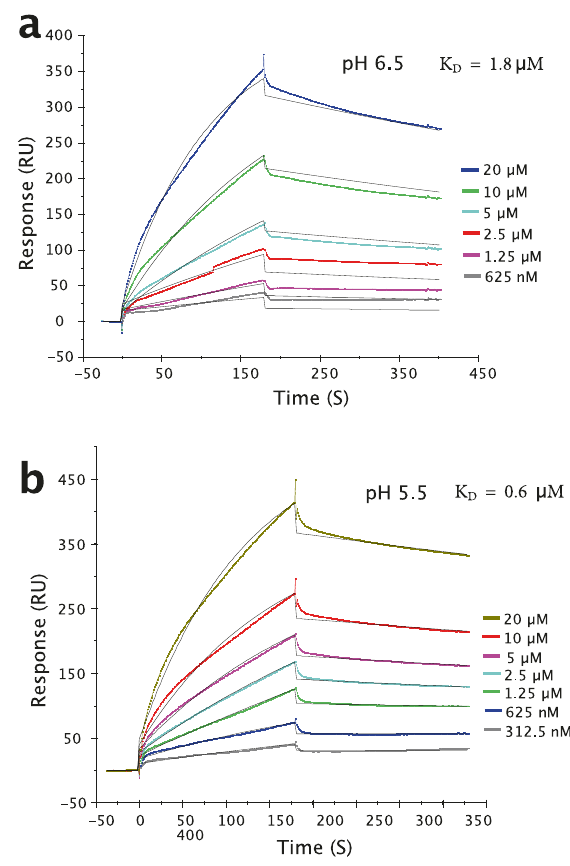
Fig. 2 SPR analysis of heparin – Cst-3 interaction. SPR sensorgrams of Cst- 3 binding to immobilized heparin at pH 6.5 ( a ) and pH 5.5 ( b ). Notice although the SPR curve looked similar, the lowest concentration of Cst-3 used at pH 5.5 is half that of at pH 6.5 (312.5 nM versus 625 nM). The black curves are curves fi t using BIAevaluate 4.0.1.